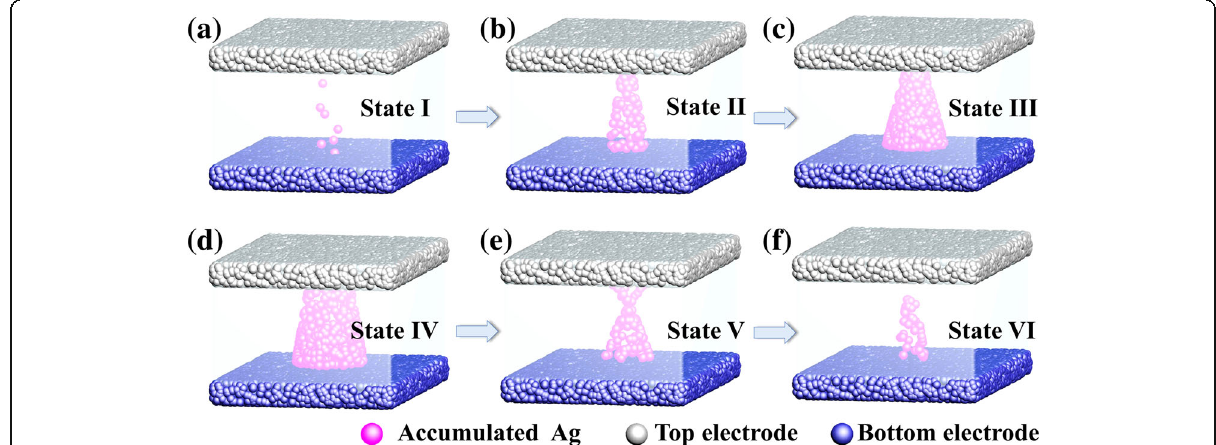
Fig. 4 a – c The schematic diagrams of forming Ag cations conductive path under consecutive positive pulses in LTP. d – f Rupture of the conductive filament after consecutive negative pulses in